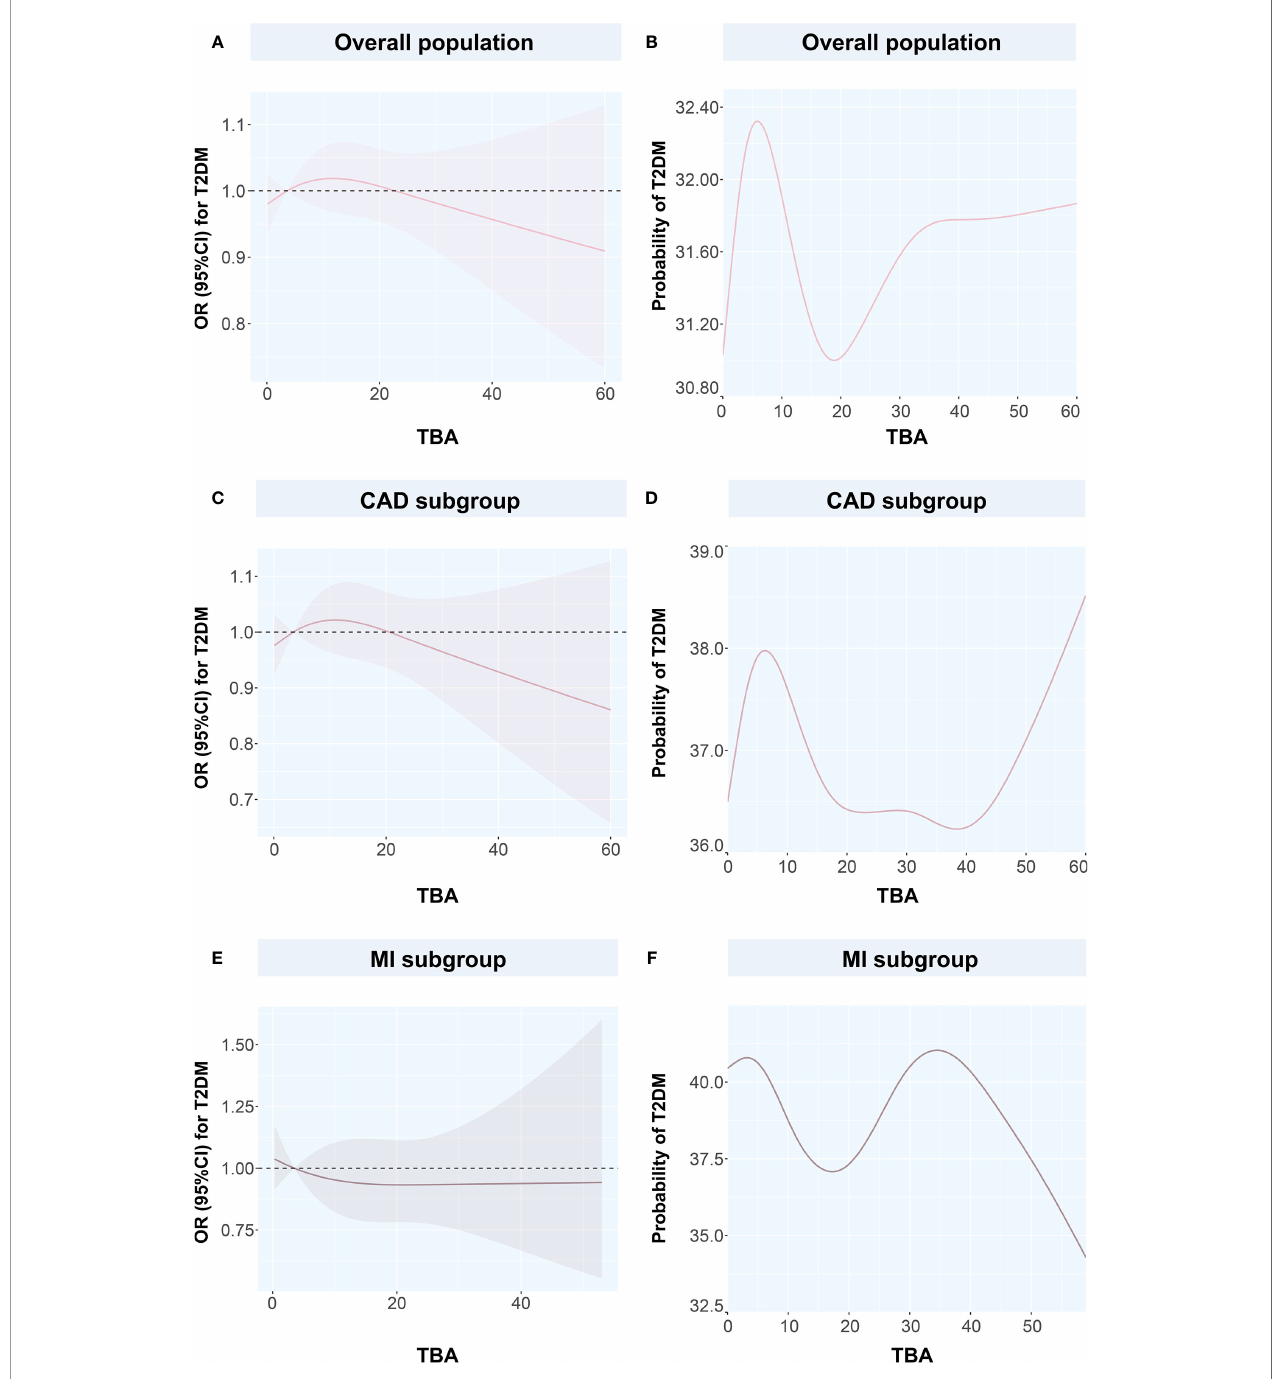
FIGURE 4 | Restricted spline curves and generalized additive models for the associations between TBA and T2DM (A) the relationship between TBA and T2DM in overall population, (B) the relationship between TBA and probability of T2DM in overall population, (C) the relationship between TBA and T2DM in CAD subgroup, (D) the relationship between TBA and probability of T2DM in CAD subgroup, (E) the relationship between TBA and T2DM in MI subgroup, (F) the relationship between TBA and probability of T2DM in MI subgroup. Solid pink lines represent the odds ratio in (A, C, E) , while represent the probability of T2DM in (B, D, F) . Pink dashed area represents the 95% con fi dence intervals in (A, C, E) . TBA, total bile acid; T2DM, type 2 diabetes mellitus; CAD, coronary artery disease; OR, odds ratio; CI, con fi dence